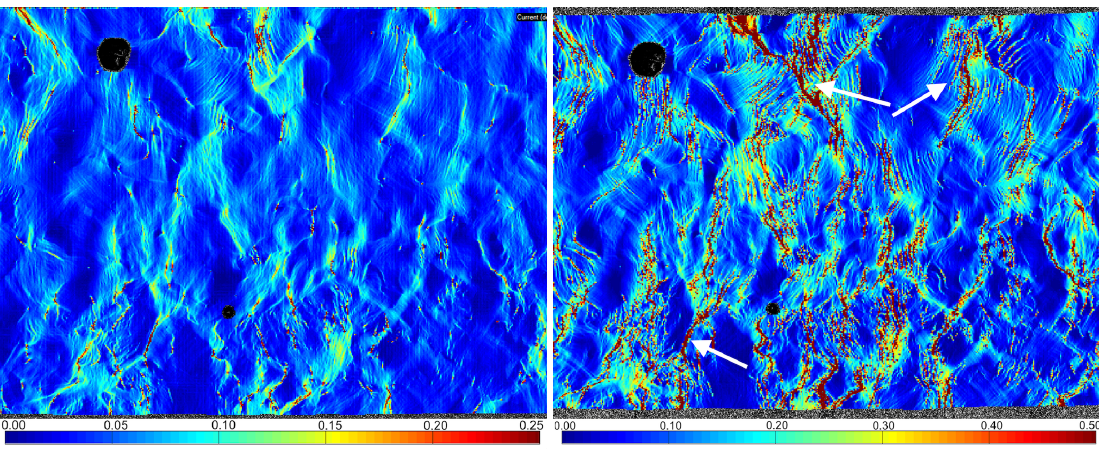
Figure 12. Measured strain field superimposed on the BSE images from Figure 11 at different global displacements in the notched specimen. ( a – d ) The strain maps relate to the force–displacement curve in Figure 6. The white arrows in ( d ) indicate the deformation bands discussed in Figure 14. In all frames, the pulling direction in the in situ SEM tensile test is from right to left. Each frame has the same dimensions, 119 µm × 90 µm. The fringe colors give values of the major principle strain.